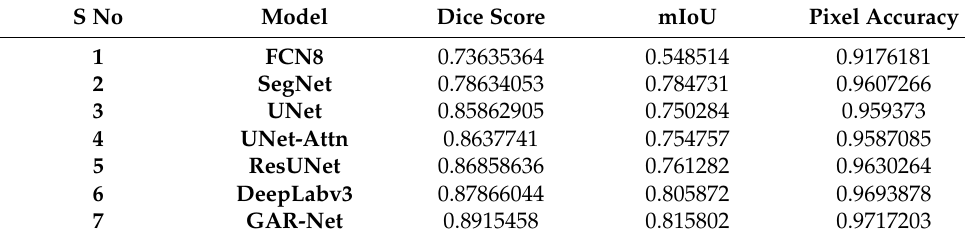
Table 2. The Results for the Kvasir-SEG